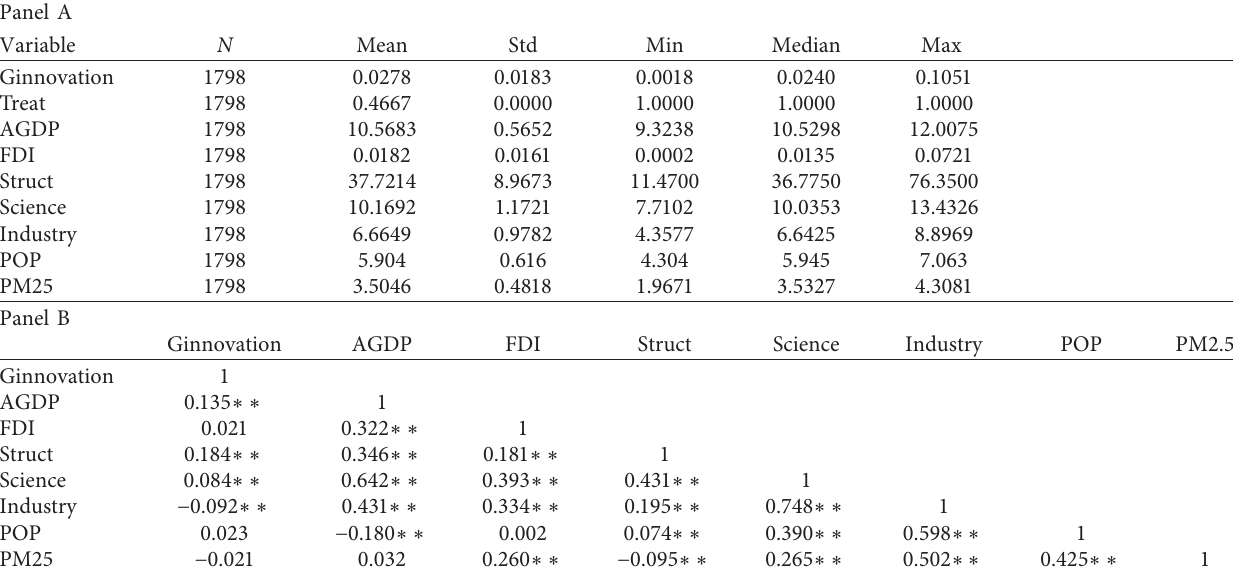
Table 2: Summary